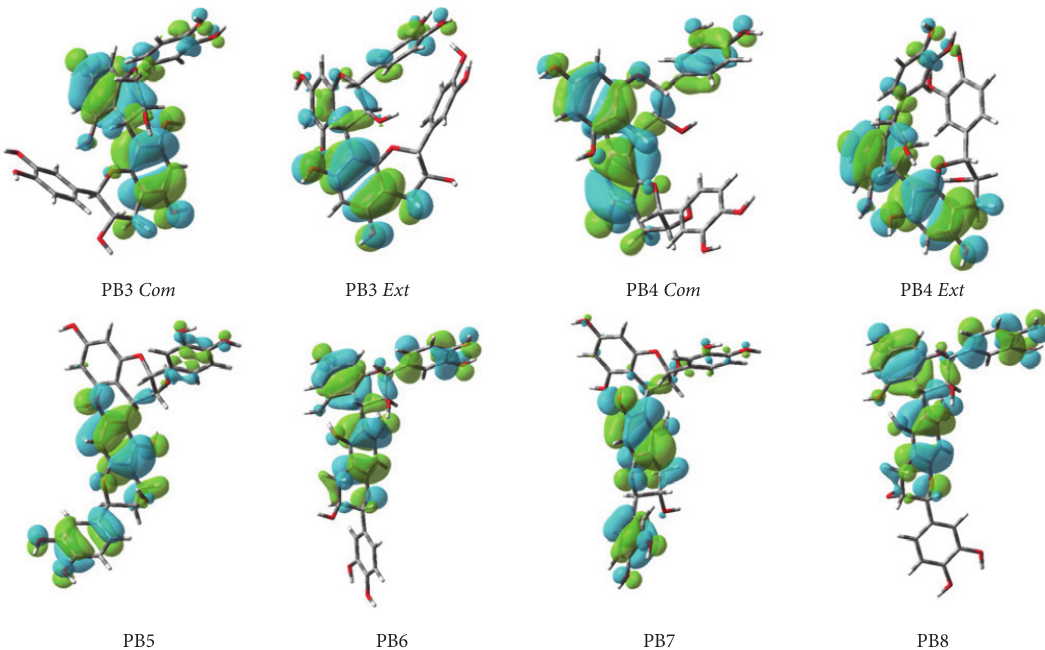
Figure 5: Charge distribution in the HOMO orbital of the procyanidin dimers optimized in aqueous medium (SMD model) using the M05- 2X/6- 31 G ∗∗ DFT method. Com : compact conformation; Ext : extended